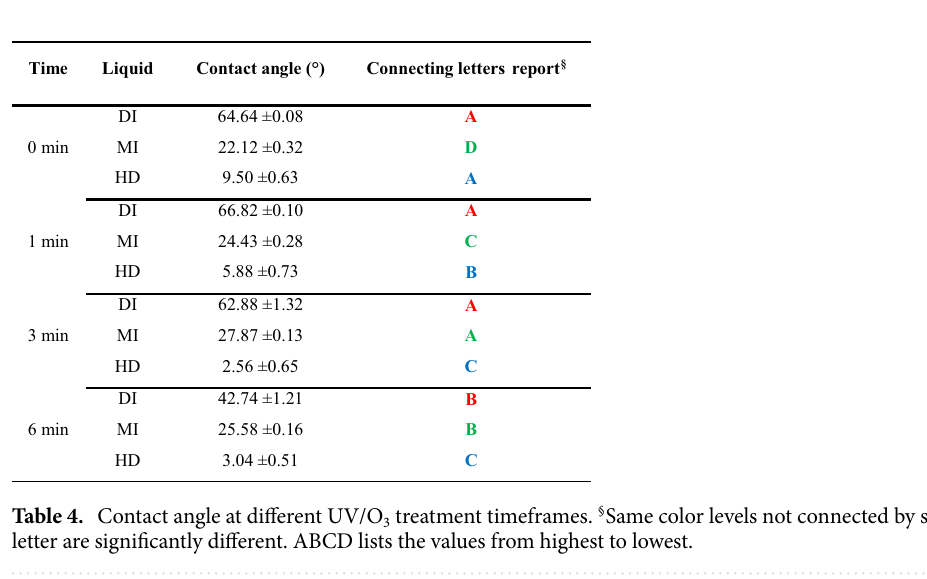
Figure 2. ContactMode™ Height images at 100 µm × 100 µm scan area of PET SBS substrate. 2-D (left) and 3-D (right) views. Z-scale for Height images is 2.0 µm. Tilt = 30°, Rotation = 15°.